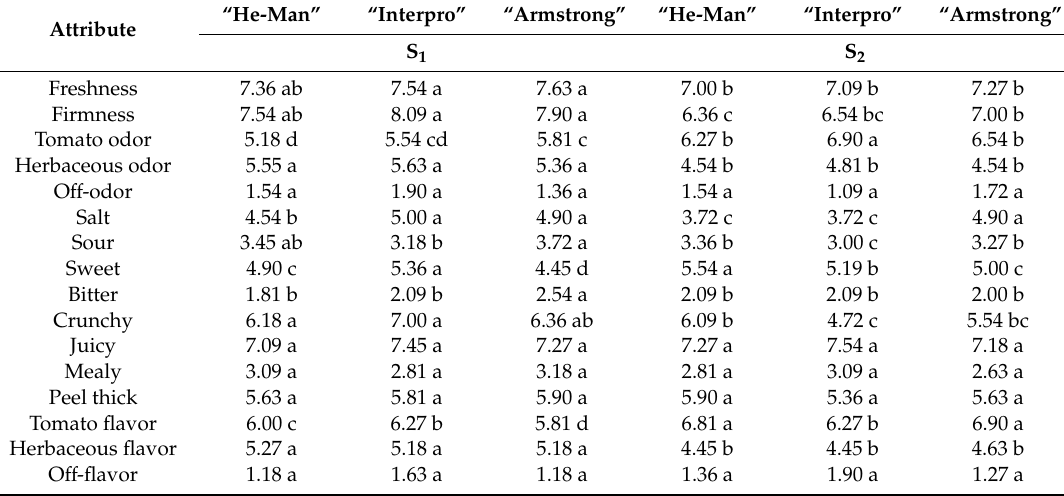
Table 6. Mean scores of 16 sensory attributes of tomatoes “Sir Elyan” di ff ering for rootstock and ripening stage. Di ff erent letters within each row indicate significance at Mann–Whitney’s U-test ( p =